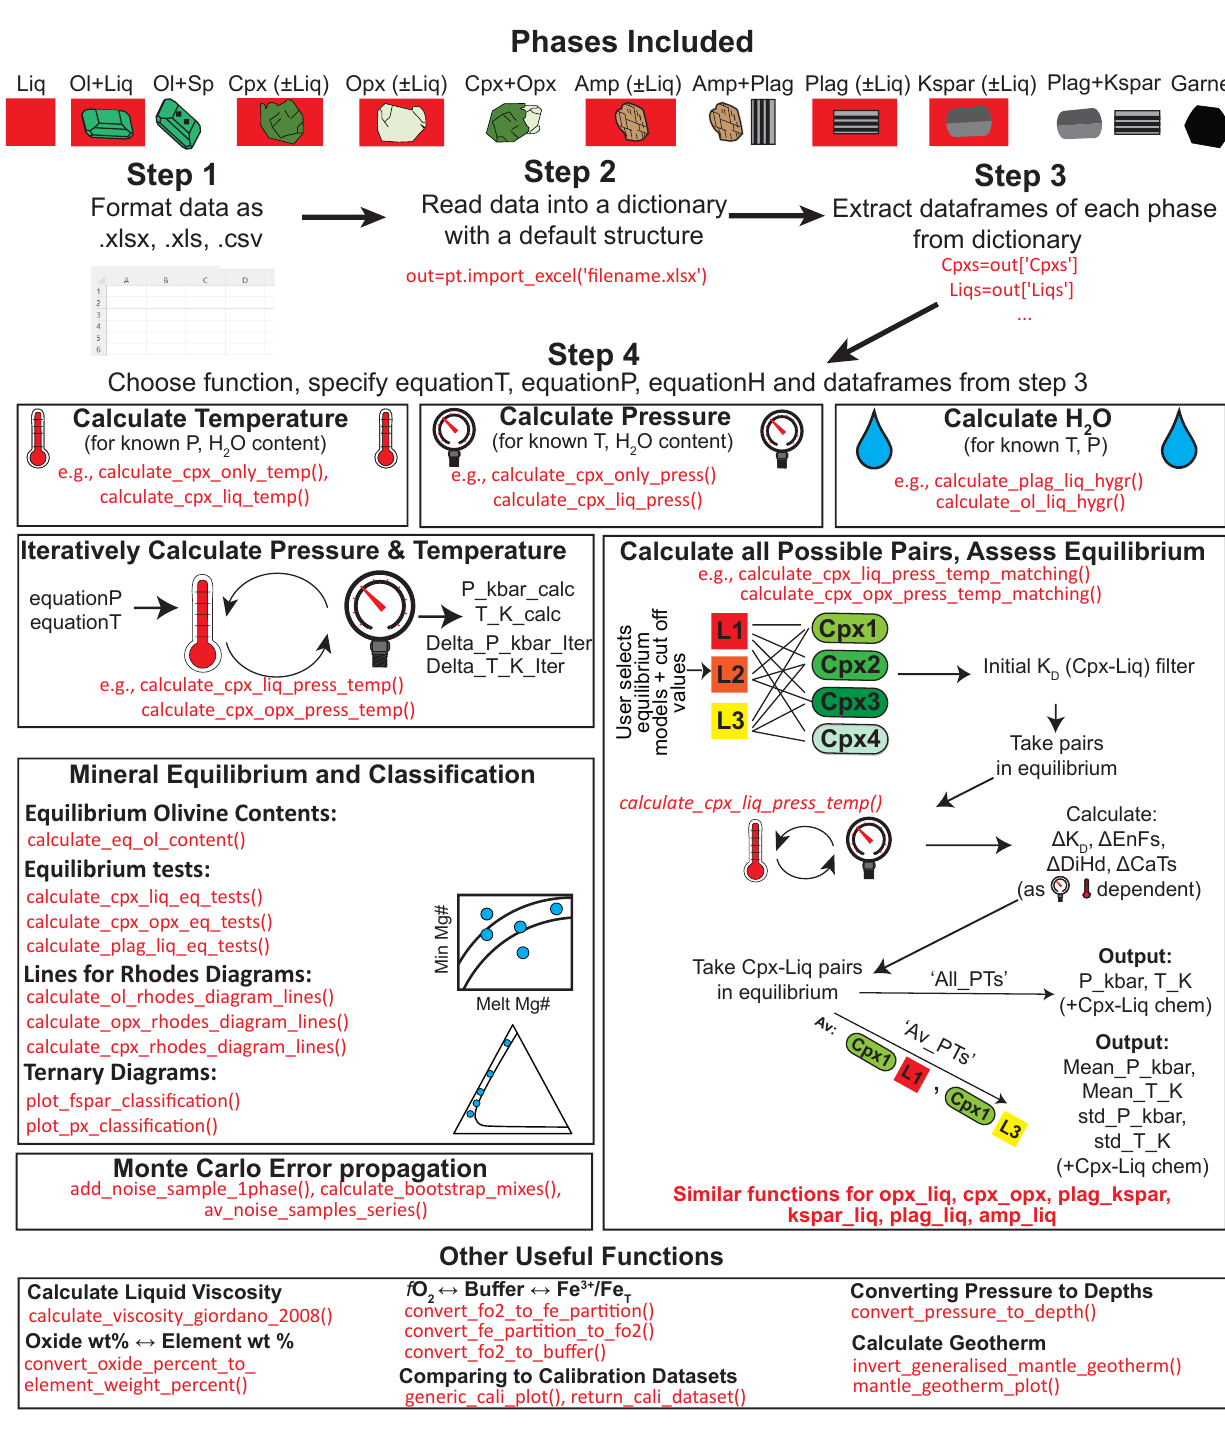
Figure 1: Schematic showing some of the functions available in Thermobar . Thermobar reads in data supplied from a spread- sheet format. The import_excel function returns data as separate dataframes for each phase, combined into a single dictionary. Once extracted from this dictionary, these dataframes can be fed into a number of different functions. In addition to simple cal- culations of T , P , and H O content, Thermobar allows users to iterate different equations for pressure and temperature, assess 2 all possible matches for pairs of phases, and perform a number of other calculations used by petrologists (e.g. calculating liquid